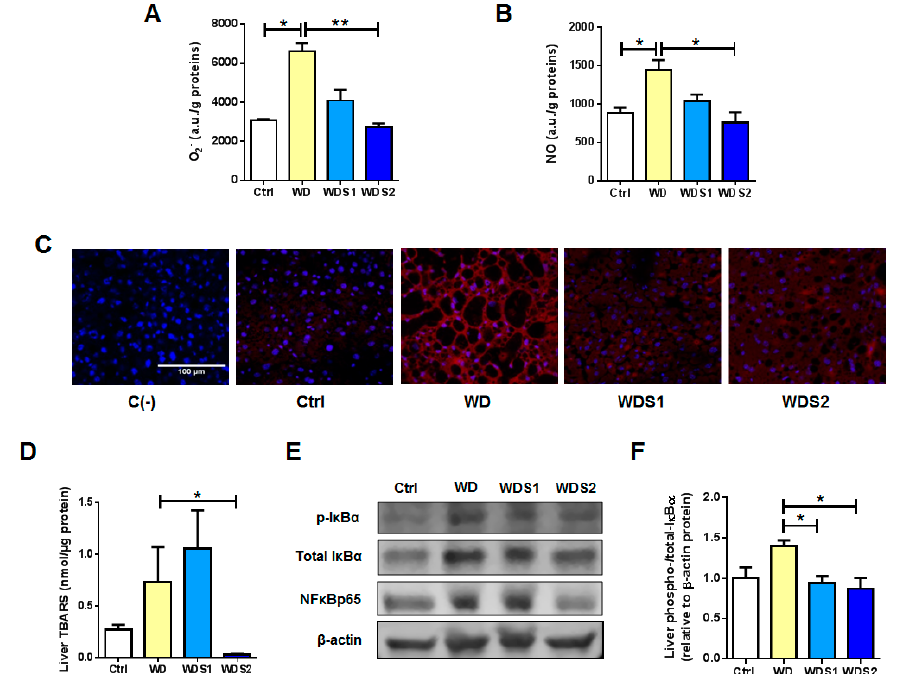
Figure 3. Spirulina liquid extract inhibits western diet induced oxidative stress and inflammation. Hepatic ( A ) superoxide anion (O 2 − ) and ( B ) nitric oxide (NO) accumulation where quantified the day of sacrifice. ( C ) Confocal images of O 2 − production in the liver detected by dihydroethidium staining in red fluorescence. Cell nuclei were visualized by DAPI in blue. C(-) negative control without dihydroethidine (DHE). Bar = 100 µm. ( D ) Quantification of hepatic thiobarbituric acid reactive substances (TBARS). ( E ) Representative blots of phospho- and total-I κ B α , NF κ Bp65 and β -actin proteins in liver. ( F ) Quantitative bar graph of liver phospho- to total-I κ B α ratio. * p < 0.05, ** p < 0.01) ( n = 4–5/group),